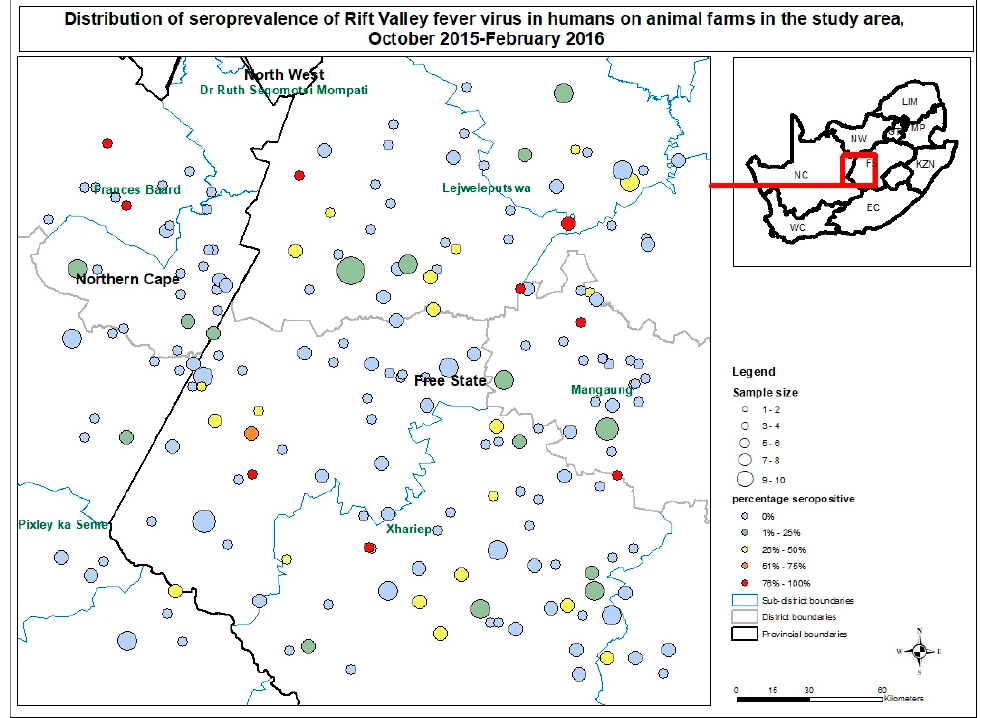
Figure 1. Distribution of anti–Rift Valley fever virus antibodies in 462 humans on 189 ruminant livestock and game farms in the study area in central South Africa, sampled during